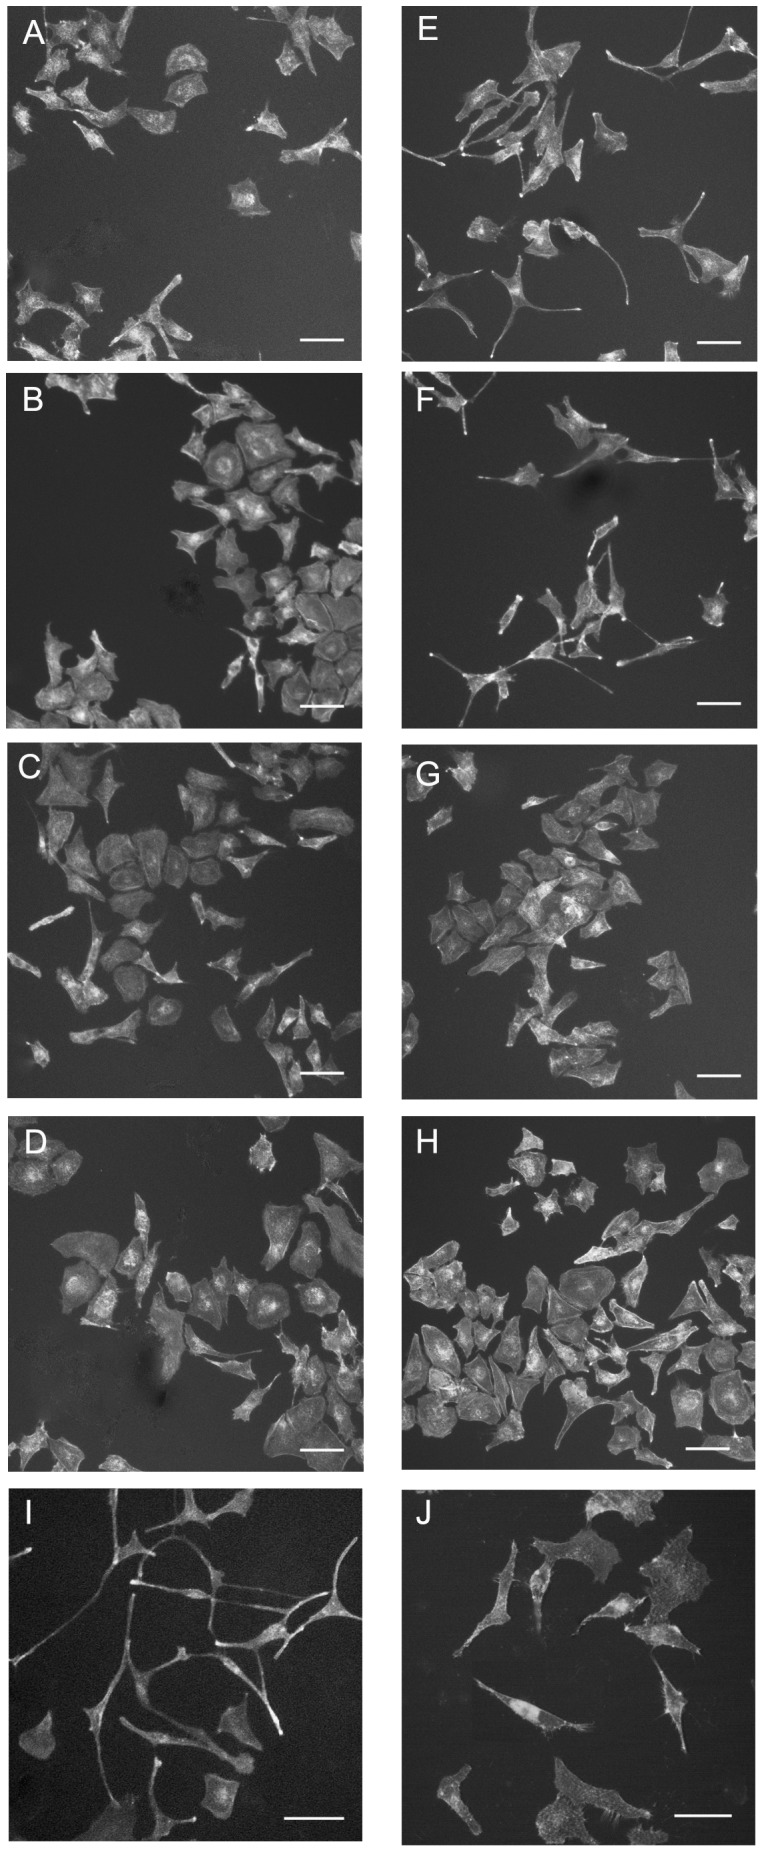
Cytoskeleton modifications of HeLa cells infected with S. meliloti queuosine biosynthesis mutants.HeLa cells were incubated with S. meliloti queC (A, E), queF (B, F), tgt (C, G), queA (D, H), the wild type 1021 strain (I) and the queF complemented strain (GMI11186) (J) in 0.5% FCS culture medium alone (A–D, I, J) or supplemented with preQ1 (E–H). HeLa cells were stained with phalloidin-Texas red and observed by fluorescence microscopy 48 hpi. Scale bar: 10 µm.